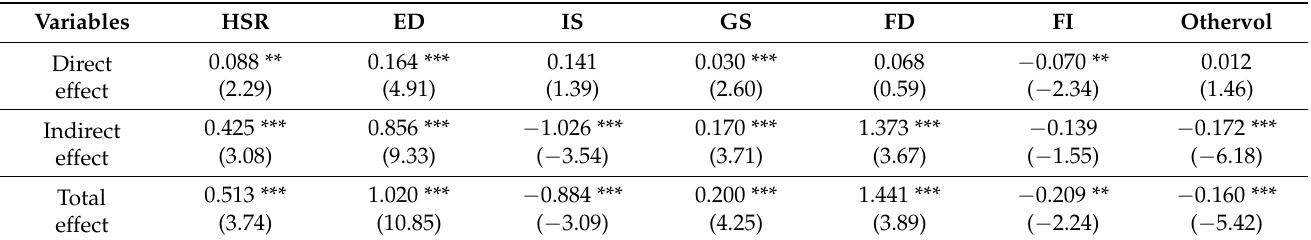
Table 8. Direct, indirect, and total effects based on the results of Model (1) in Table